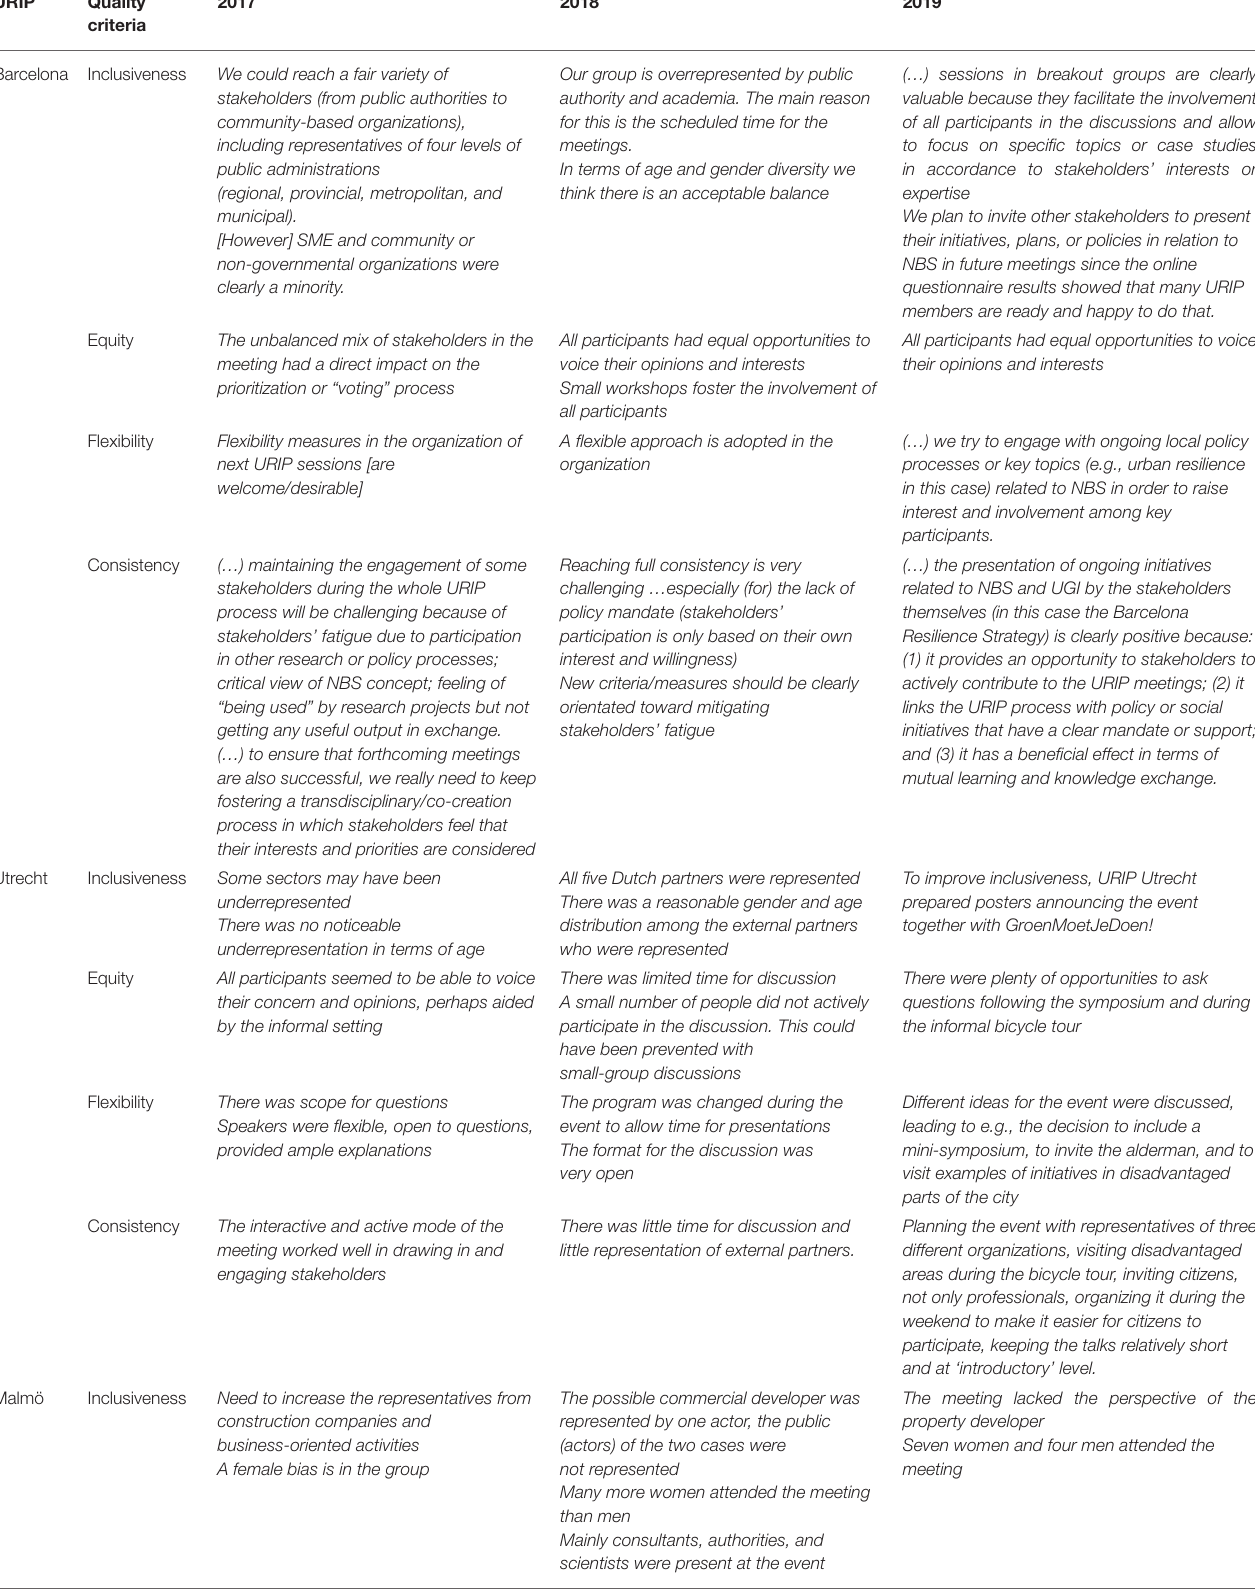
TABLE 5 | An extraction of significant statements from the Summary Reports of URIPs.